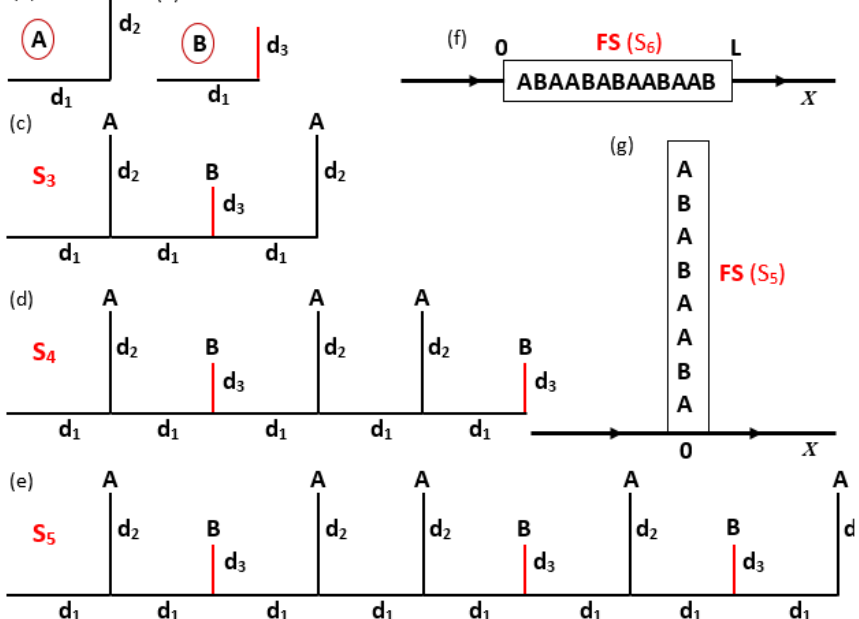
Figure 1. Schematic representation of blocks A and B constituting the Fibonacci structure. ( a ) The block A consists of a horizontal coaxial cable of length d 1 combined with another identical vertical stub of length ( d 2 = d 1 ). ( b ) The Block B is similar to the block A but with the length of the vertical stub of length d 3 = d 2 /2. All cables are characterized by the same impedance Z . ( c – e ) give the shape of the Fibonacci sequences S 3 , S 4 and S 5 respectively. ( f ) A finite Fibonacci structure (6th generation) inserted horizontally between two semi-infinite waveguides. ( g ) A finite Fibonacci structure (5th generation) grafted vertically along a